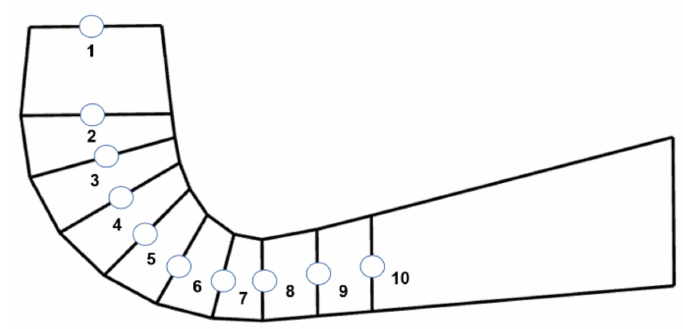
Figure 15. Experimental observation of vortex rope in draft tube of a turbine with a runner diameter of 0.35 m [28].